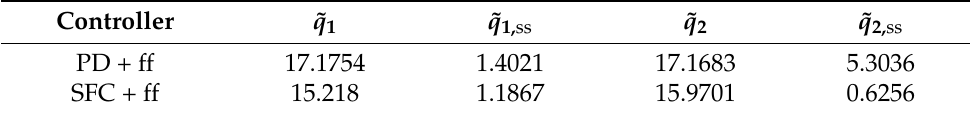
Table 8. RMS Position Error comparative for the experimental